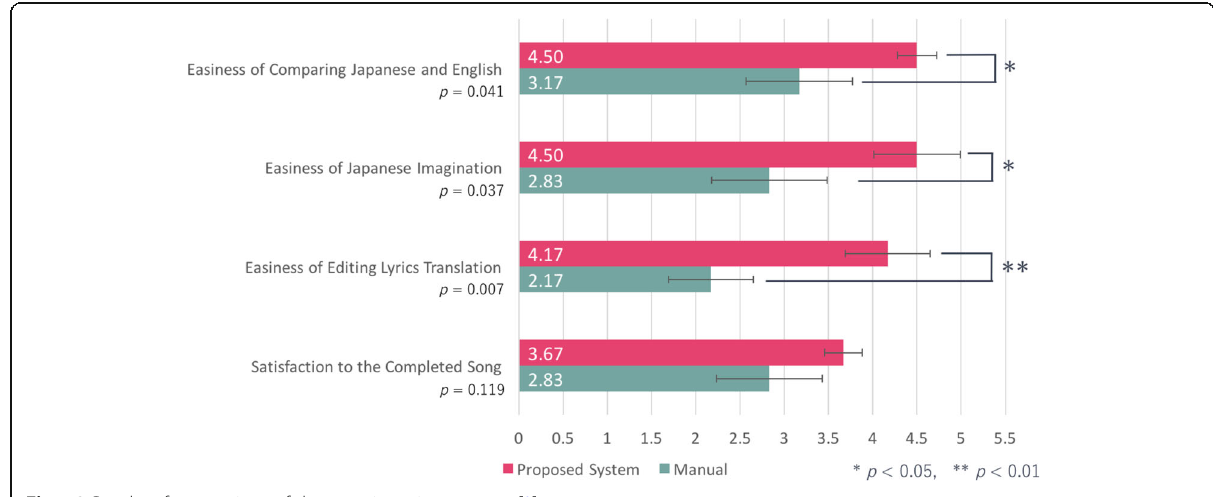
Fig. 13 Results of comparison of the questionnaire contents